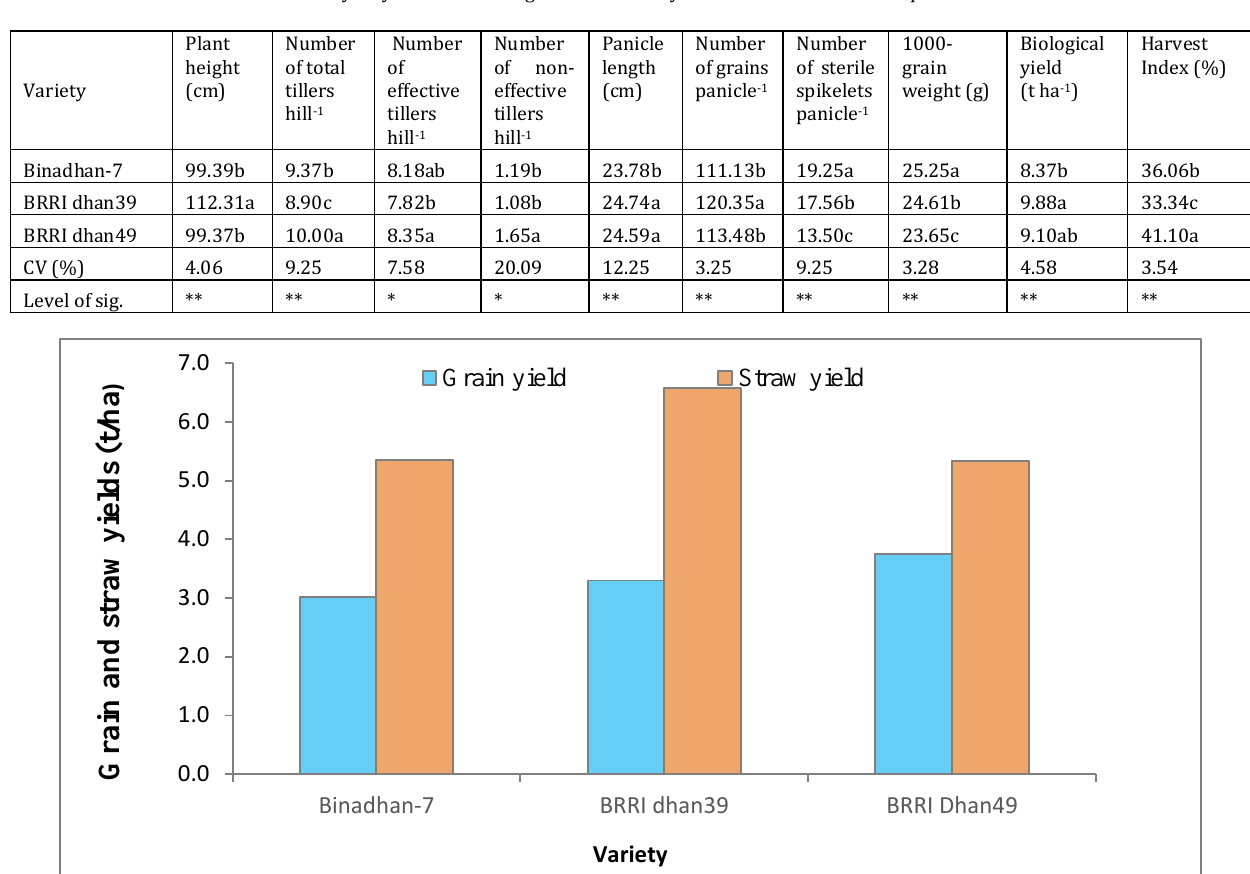
Table 1: Effect of variety on yield contributing characters and yield of short duration transplant Aman rice varieties